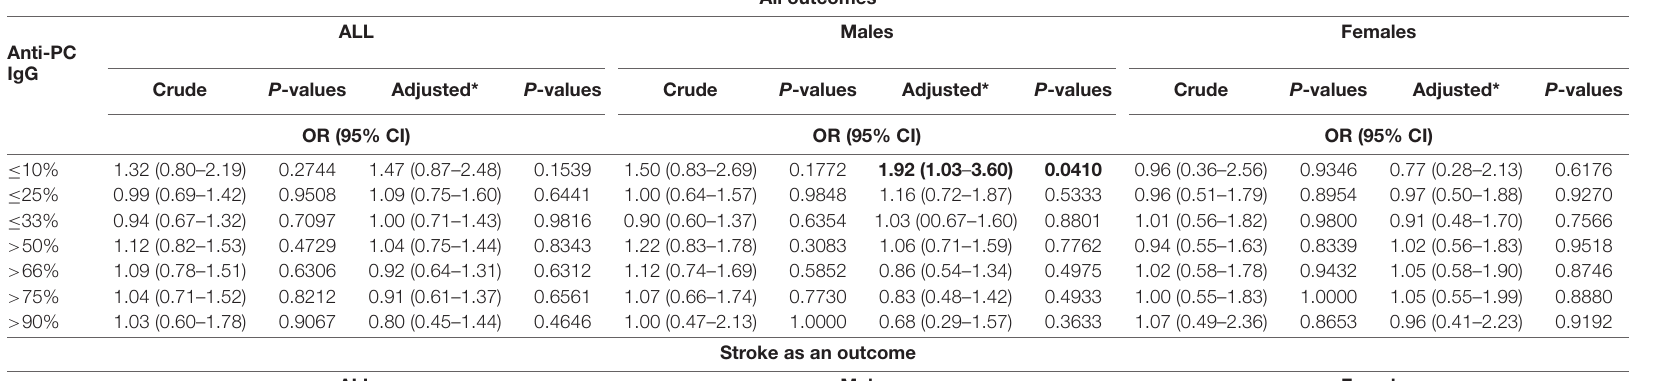
TABLE 2 | Association between levels of IgG anti-phosphorylcholine (PC) and risk for cardiovascular disease (CVD), stroke, and myocardial infarction (MI) among all participants and men and women. All